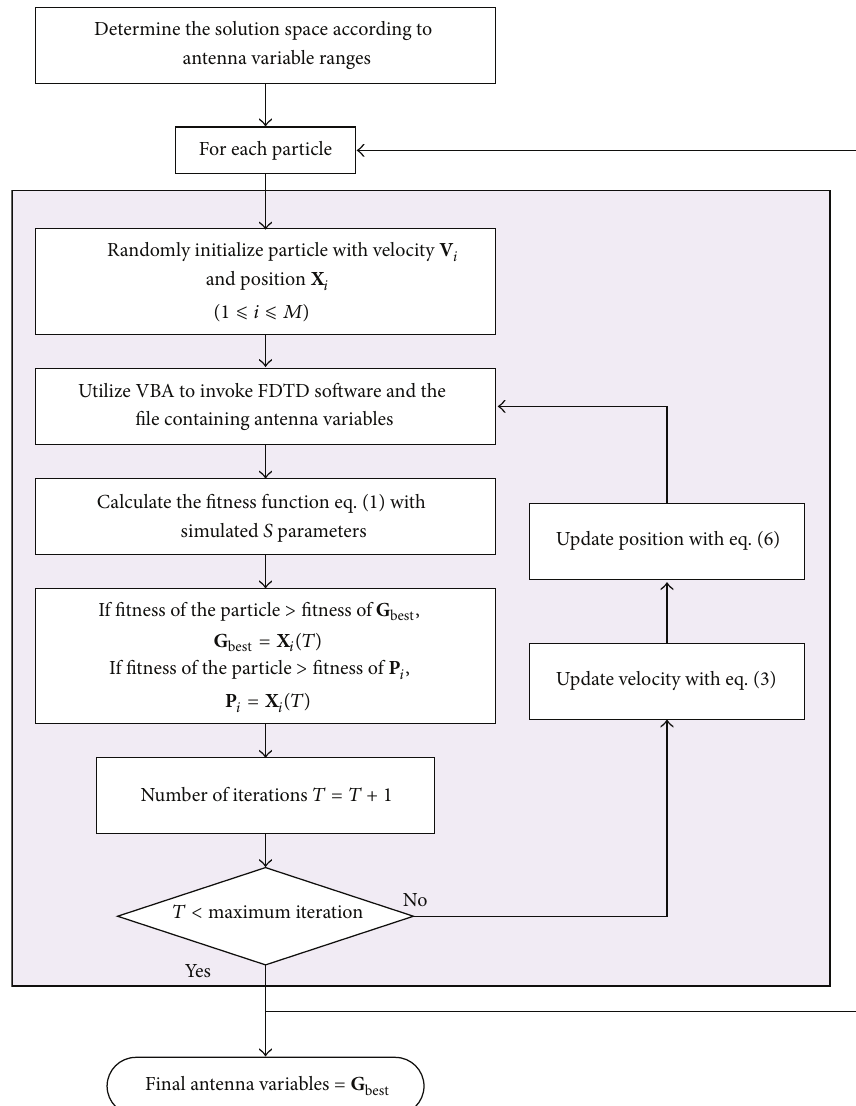
Figure 2: Flow chart of the proposed antenna cooptimization